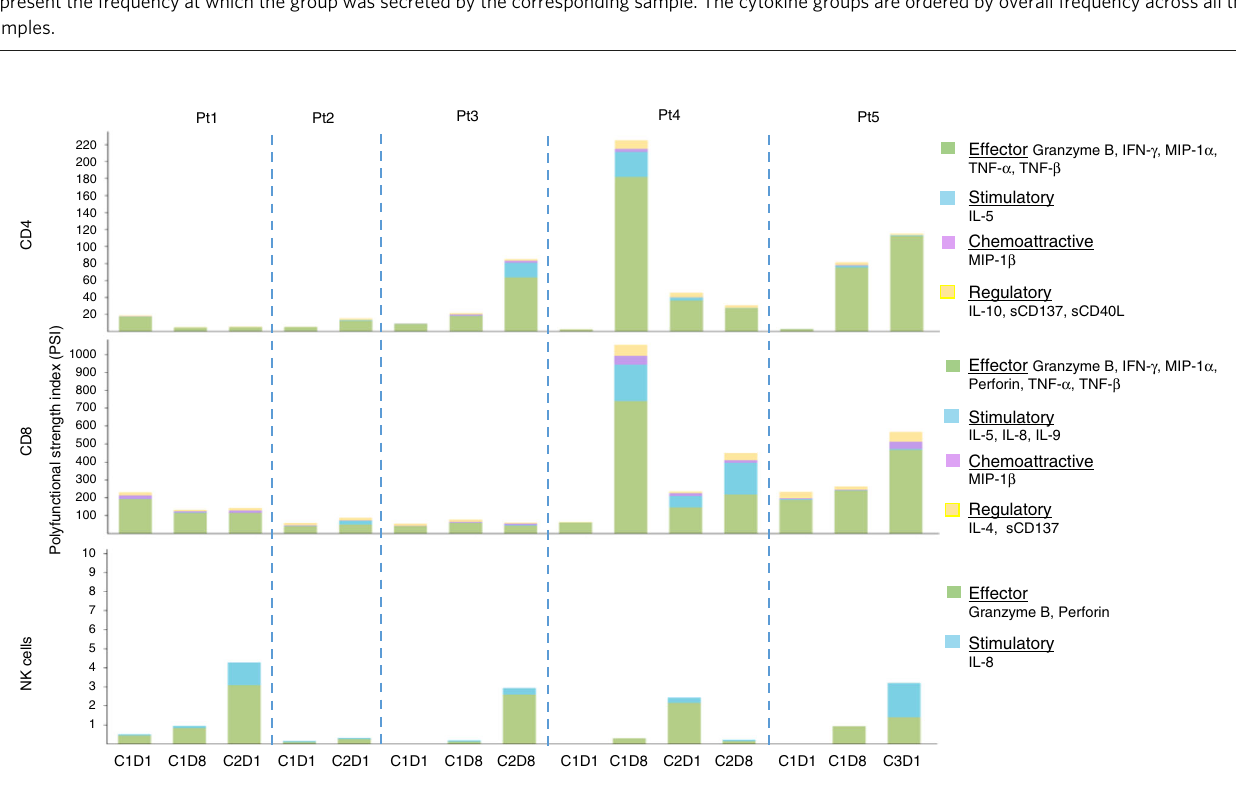
Fig. 6 Increase in polyfunctional T and NK cells in PBMC of patients receiving NKTR-214. Single-cell polyfunctional strength index (PSI) computed for CD4, CD8 T cells and NK cells across 5 patients at different time-points. C1D1: cycle 1 day 1; C1D8: cycle 1 day 8; C2D1: cycle 2 day 1; C2D8: cycle 2 day 8; C3D1: cycle 3 day